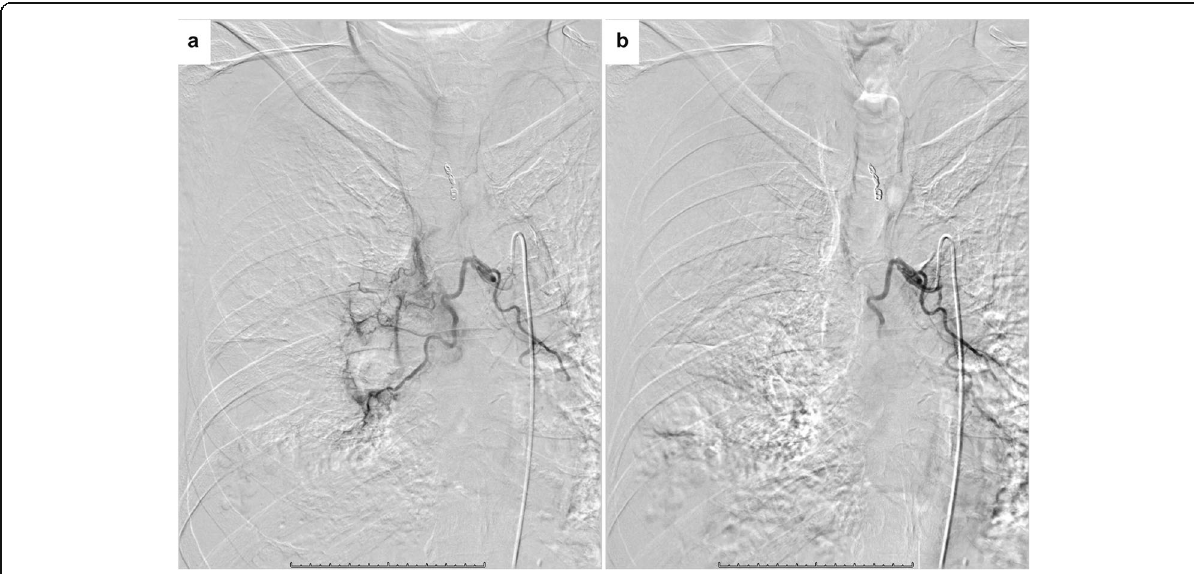
Fig. 5 A Selective angiogram of the common bronchial trunk shows normal bilateral bronchial arteries. B Only right BA was selectively embolized with gelatin sponge